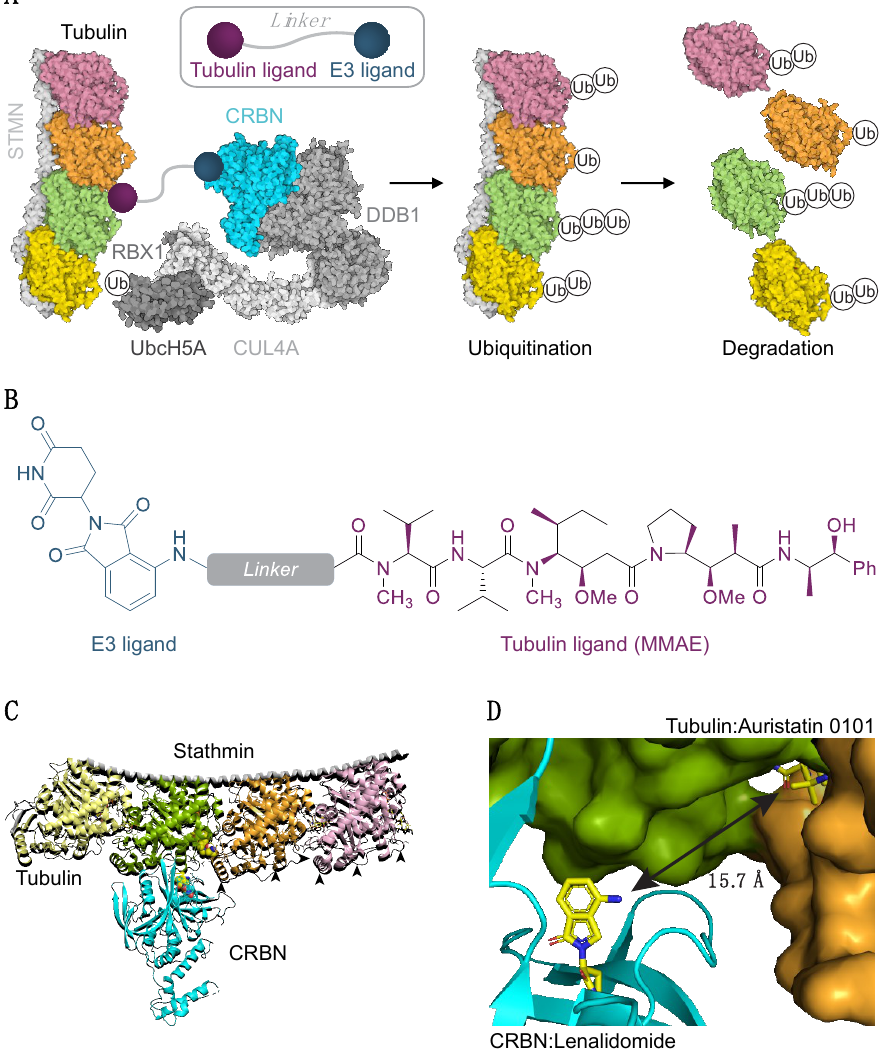
Figure 1. Experimental strategy to degrade tubulin using the PROTAC technology. ( A ) Schematic diagram of protein degradation strategy. Recruitment of the E3 ligase to tubulin heterodimer via the tubulin / E3 ligand molecule would cause tubulin ubiquitination (Ub) and subsequent proteasome-mediated degradation. Structure of two tubulin heterodimers (pink, orange, green, yellow) bound to stathmin (STMN, PDB ID 4x1i) and the CRL4 CRBN E3 ligase complex is shown (RBX1 / CUL4 / DDB1, PDB ID 4a0K; CRBN PDB ID 5fqd; UbcH5A, PDB ID 2c4p). ( B ) Structure of a chimeric compound. ( C ) Docking pose of CRBN and tubulin. Arrowheads indicate some of the exposed lysine residues in tubulins. ( D ) The shortest pairwise distance between lenalidomide and auristatin-0101 from pose in ( C ) is permissive of the degrader approach.